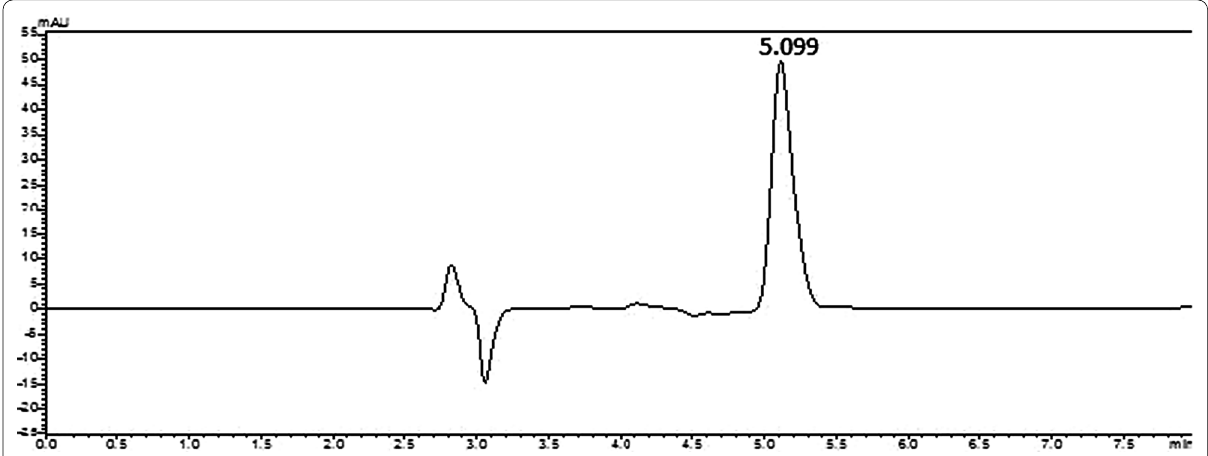
Fig. 2 Sharp peak of Mupirocin calcium in mobile phase methanol: water (75: 25) pH adjusted to 4 with acetic acid at 221 nm with R T 5.09